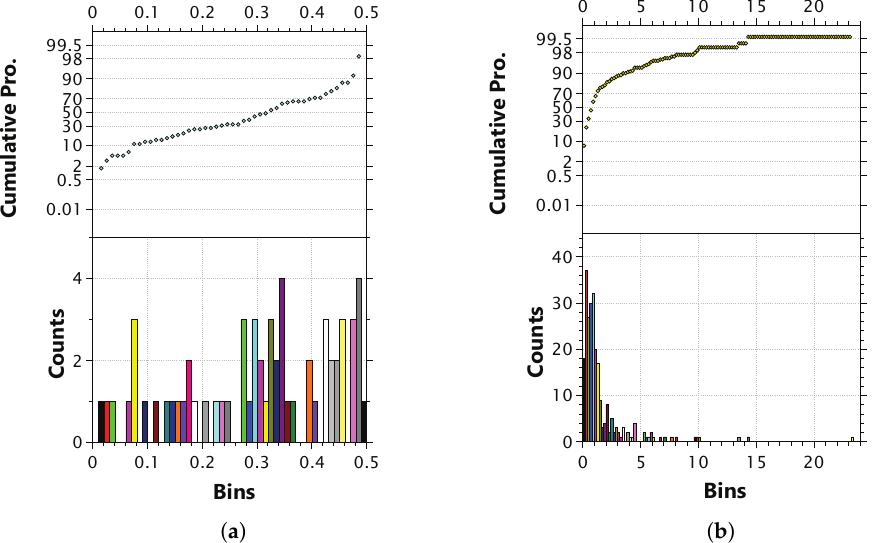
Figure 9. Counts and cumulative probability of the MAF values ( a ) and z scores ( b ) of the real data . The abscissa is the MAF values and z scores , the lower half of the ordinate is the number of MAFs/ z scores in each interval of the histogram, and the upper half of the ordinate is the cumulative probability of each interval in the histogram. ( a ) MAF analysis. ( b ) z α and z β